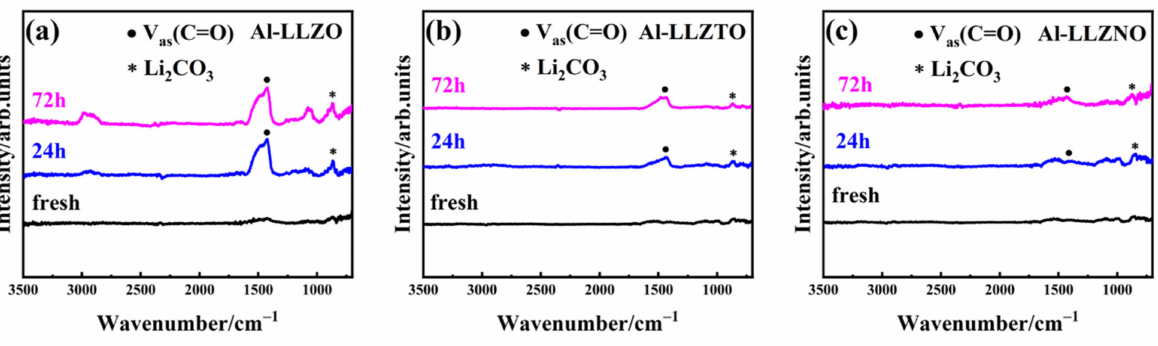
Figure 4. FTIR spectra of as-prepared, 24 h air-exposed, and 72 h air-exposed ( a ) Al-LLZO, ( b ) Al-LLZTO, and ( c )